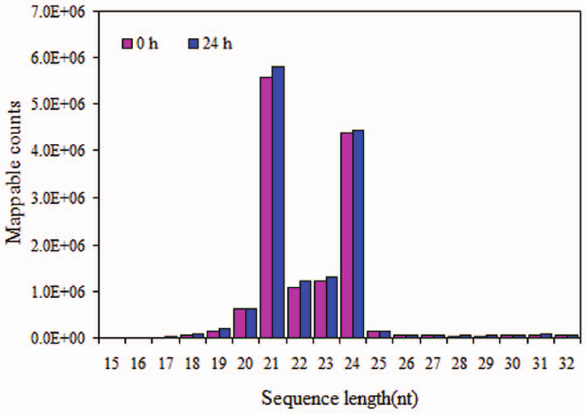
Figure 1. Length distribution of mappable counts of sequ-seqs type in two libraries of strawberry